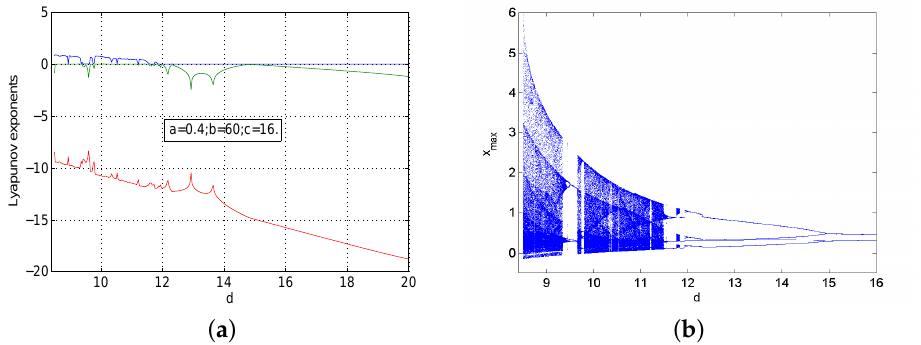
Figure 7. The Lyapunov exponents spectrum and the bifurcation diagram of system (1) with ( a , b , c ) = ( 0.4,60,16 ) and 8.49 < d < 20 at the initial values ( 0.01,0.01,0.01 ) T : ( a ) Lyapunov exponents; ( b ) bifurcation